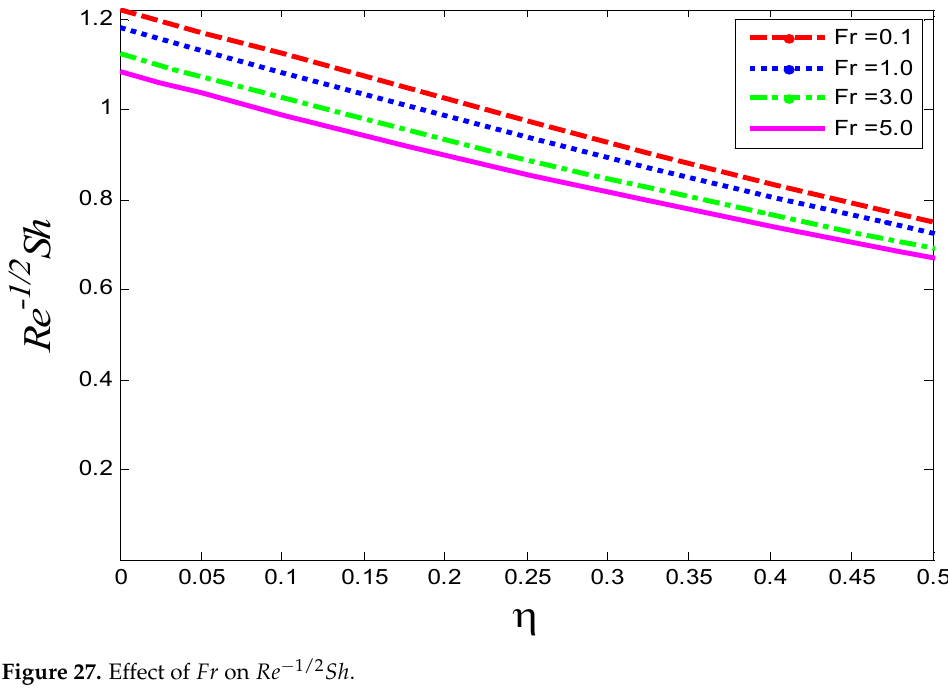
Figure 27. Effect of Fr on Re − 1/2 Sh 4.1. Influence of Involved Parameters on Velocity Profile 𝑓 (cid:4593) (cid:4666)𝜂(cid:4667), Temperature Profile 𝜃(cid:4666)𝜂(cid:4667) , and Mass Concentration 𝜙(cid:4666)𝜂(cid:4667)